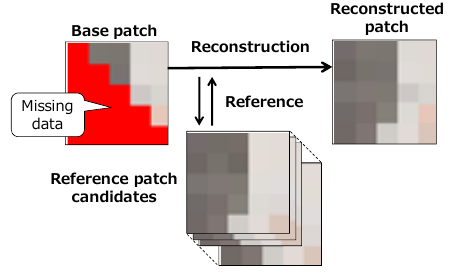
Figure 8. Checklists in structure inspection based on MLIT’s